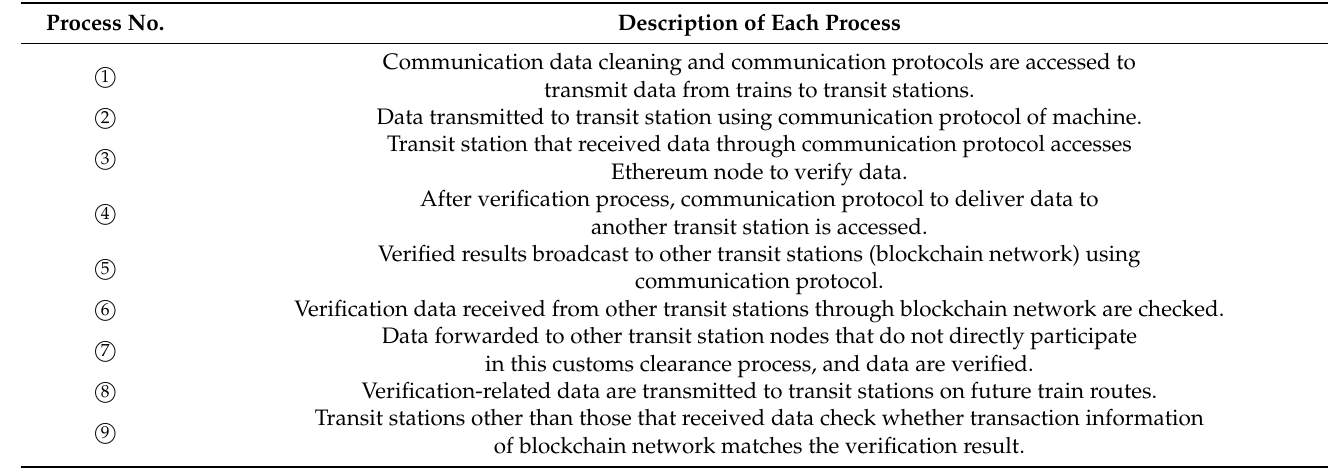
Table 2. Process of non-stop customs clearance on blockchain